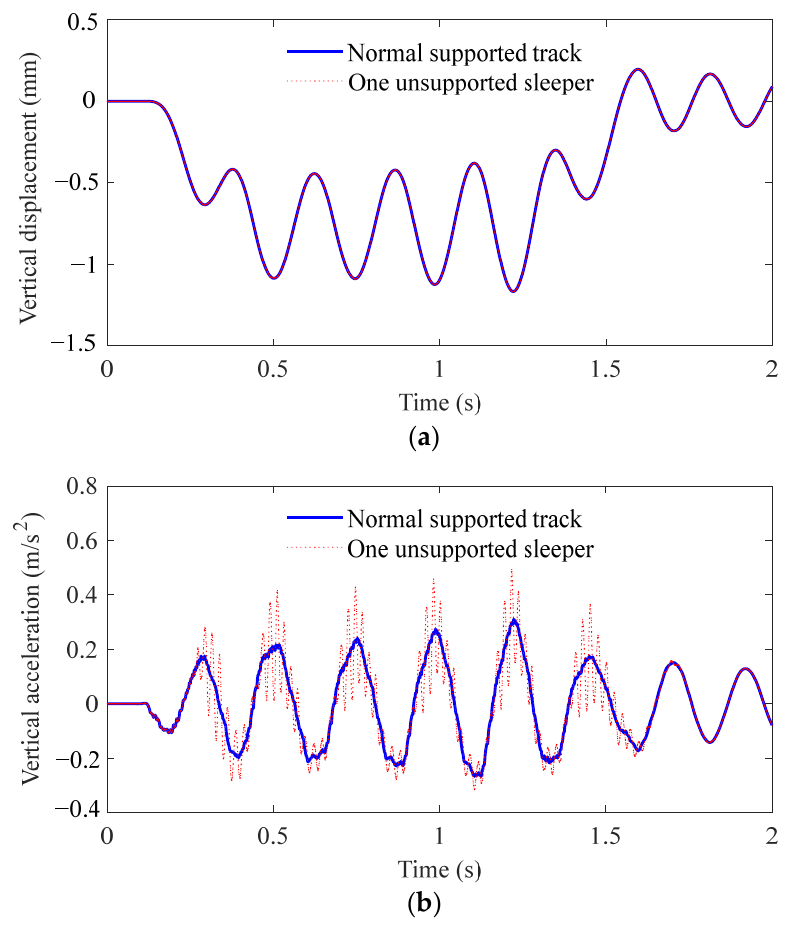
Figure 6. Dynamic responses under the bilateral unsupported sleeper at point B: ( a ) midspan displacement of the bridge and ( b ) midspan acceleration of the bridge.